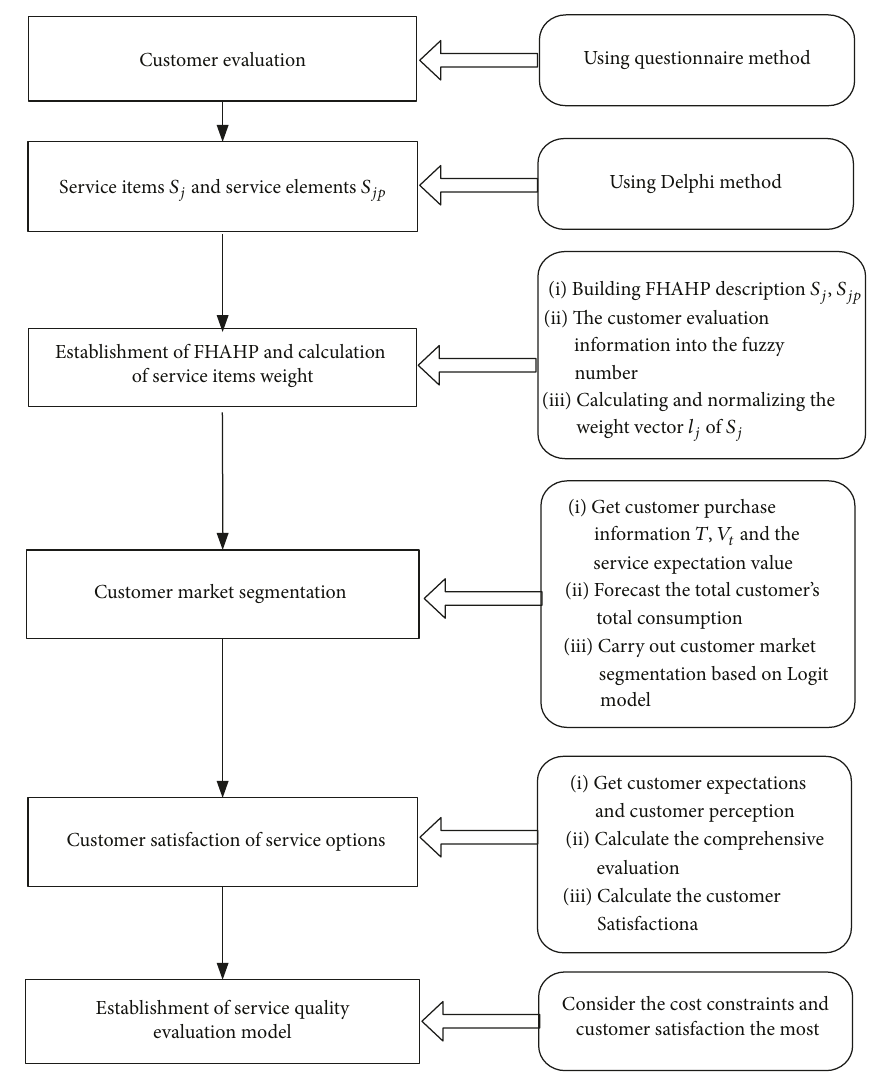
Figure 2: The framework of the proposed